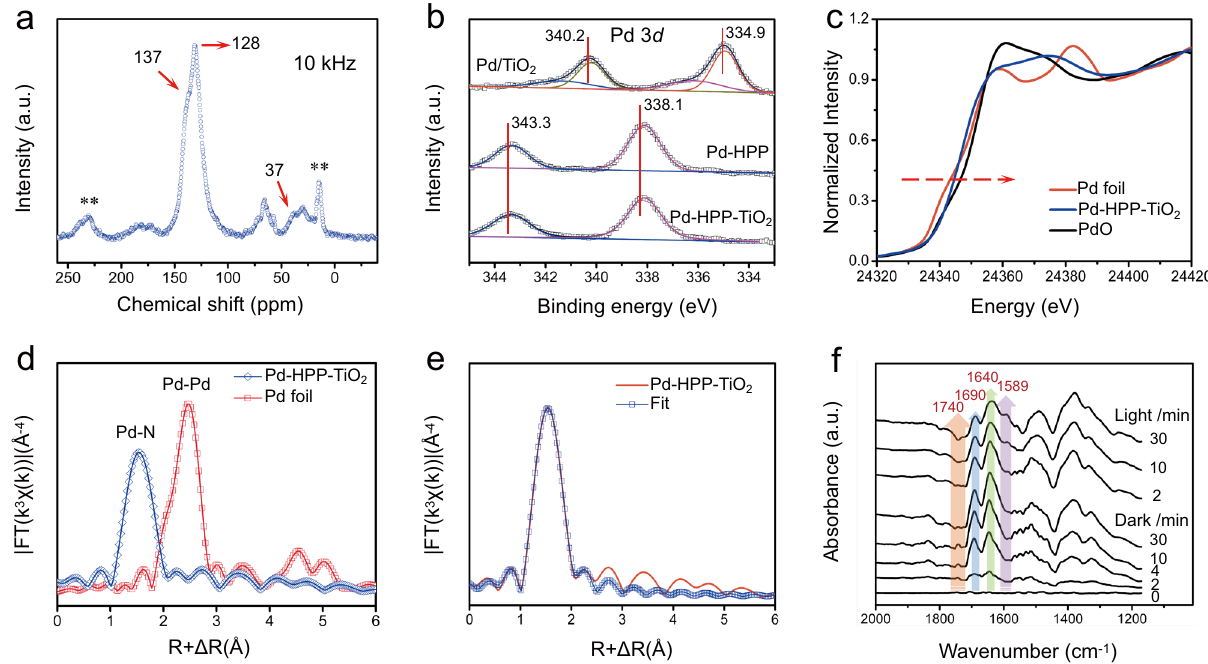
Fig. 5 Chemical structure analysis and surface species evolution of Pd-HPP-TiO 2 . a Solid-state 13 C CP-MAS NMR spectrum. b Comparison of Pd 3 d XPS spectra for three photocatalysts. c Pd K-edge XANES and d Fourier transformed EXAFS spectra of Pd-HPP-TiO 2 and references. e Fourier transformed EXAFS spectrum of Pd-HPP-TiO 2 and fi tting curve. f In situ DRIFTS test of gas adsorption on Pd-HPP-TiO 2 in the dark and during the photocatalytic CO 2 reduction under UV-visible light